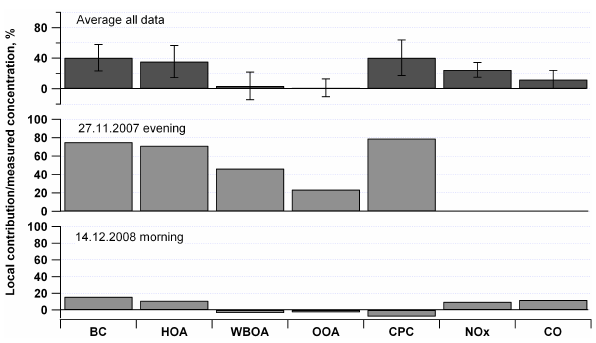
Figure 8: Percentage of local contributions to total measured concentrations for different components (average of all data ± 1 standard deviation, top panel) and 2 measurement drives. Note that for NO X and CO (top panel) only part 2 data were included in the average (not measured for part 1). The percentage of background contributions to total measured concentrations can be derived from this plot by subtracting the value denoted by the bars from 100%: ~60% for BC, HOA, and CPC, close to 100% for WBOA and OOA, ~90% for NO X and CO.